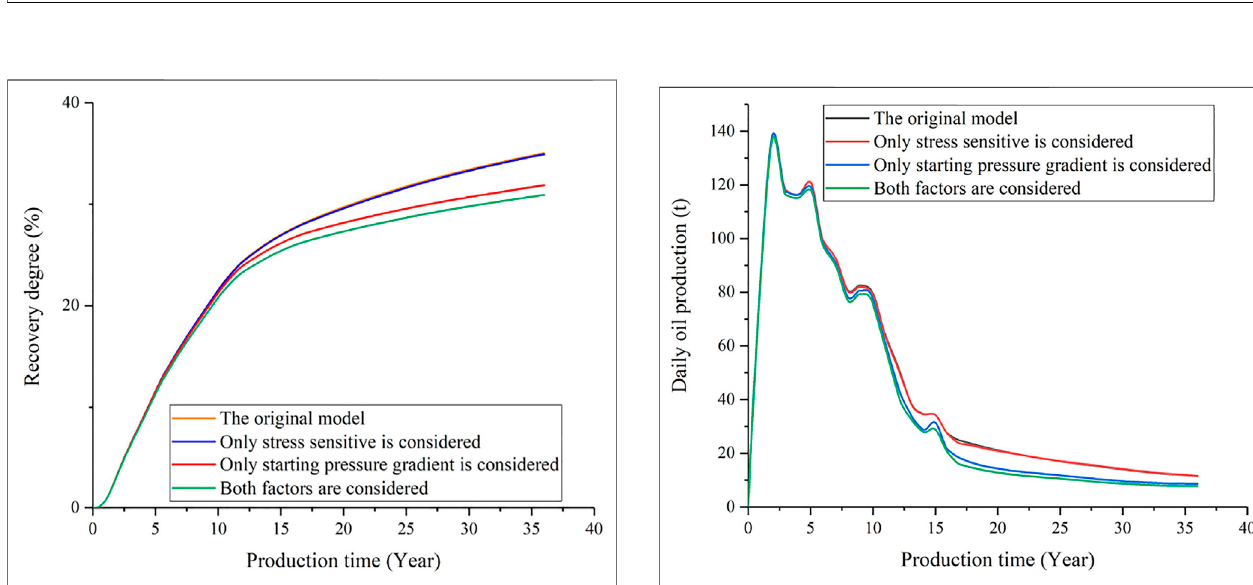
FIGURE 11 | Schematic diagram of geological model of the target layer in the study area.